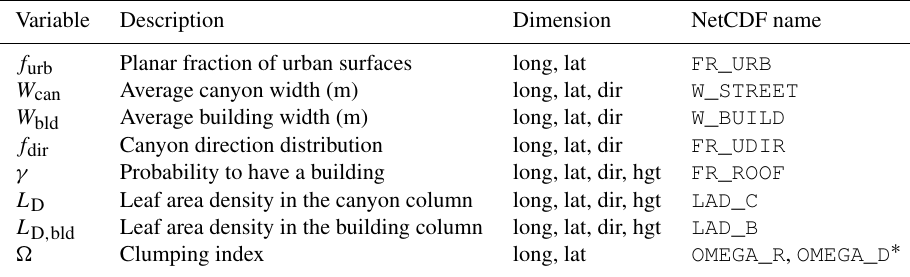
Table A1. Urban canopy parameters required as input to